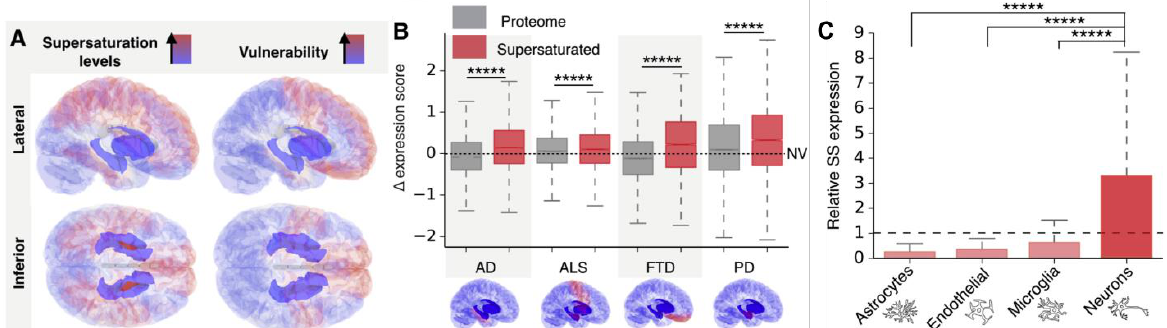
Figure 4. Supersaturation correlates with tissue and cell vulnerability in neurodegenerative diseases (reproduced with permission from Freer et al., 2019 [69]). ( A ). Red regions indicate elevated expression of supersaturated proteins relative to the proteome (left), which are also the tissues most vulnerable to neurodegeneration in the early stages of AD, PD, frontotemporal dementia (FTD), and amyotrophic lateral sclerosis (ALS) (left). ( B ). Scores of the top 5% of supersaturated proteins calcu- lated for AD, PD, ALS, and FTD. ( C ). Relative expression of supersaturated proteins in different cell types. ***** p < 0.0005.